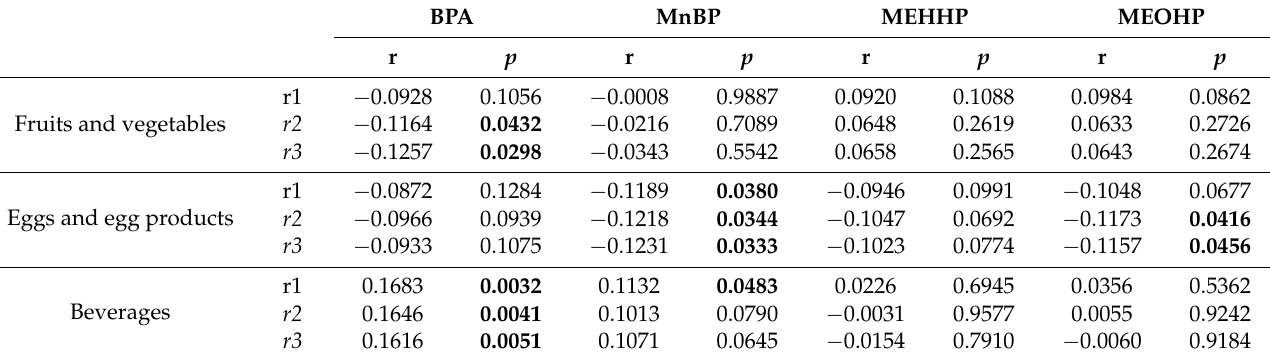
Table 4. Pearson’s partial correlation coefficients between food intake and urinary BPA and phthalates concentration a ( n =